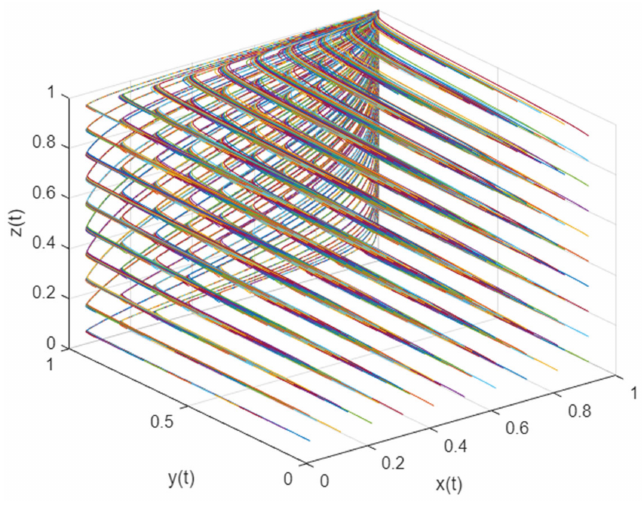
Figure 5. Parameter running track in the tripartite game